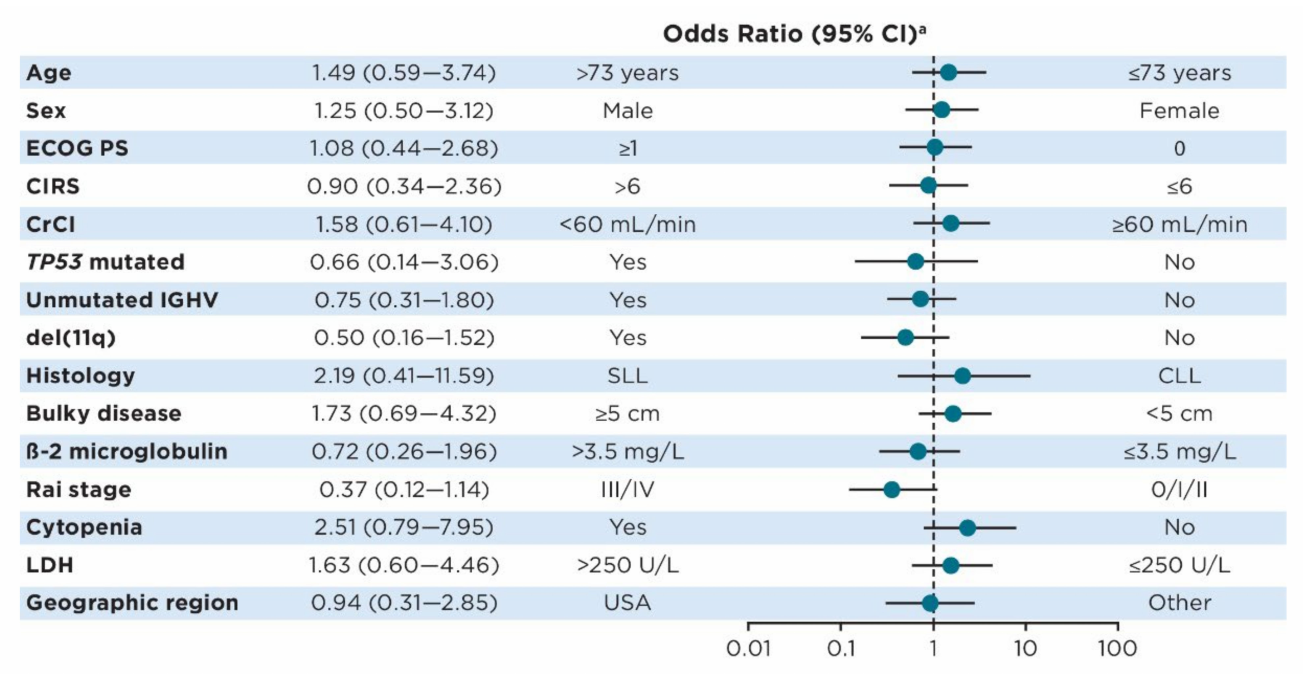
Figure 1. Forest plot of odds for continued ibrutinib treatment at 5 years according to baseline characteristics. a Odds ratios < 1 favor achievement of ≥ 5 years of ibrutinib treatment for the subgroup to the left of the plot, while odds ratios > 1 favor achievement of ≥ 5 years of ibrutinib treatment for the subgroup to the right of the plot. Abbreviations: CIRS, Cumulative Illness Rating Scale; CrCl, creatinine clearance; ECOG PS, Eastern Cooperative Oncology Group performance status; IGHV, immunoglobulin heavy chain variable region; LDH, lactate